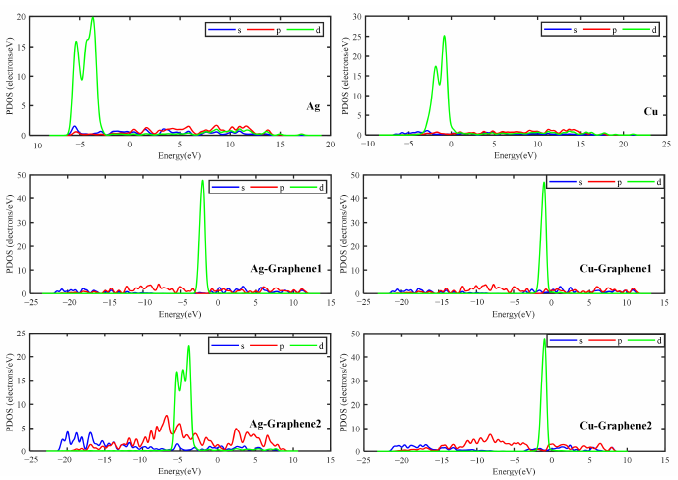
Figure 6. PDOS of different electrode plates.